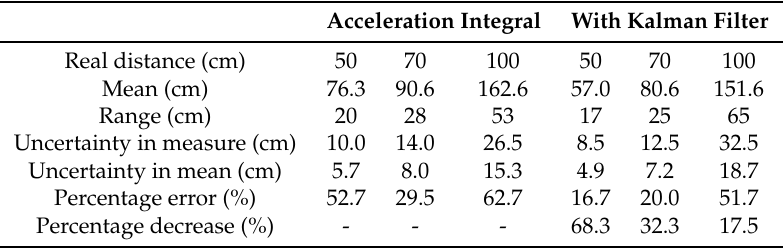
Table 6. Displacement in the space measured with the